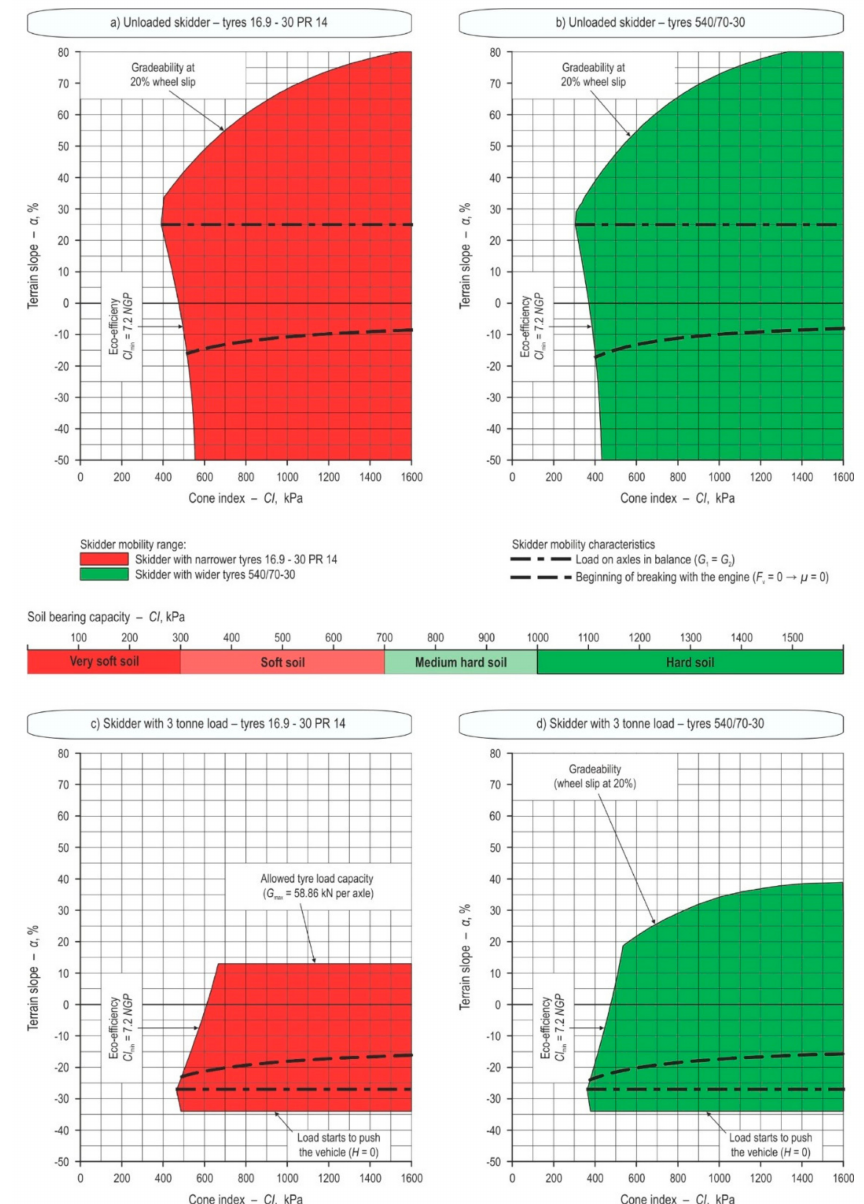
Figure 2. Mobility range of an unloaded skidder and a skidder with 3 tonne